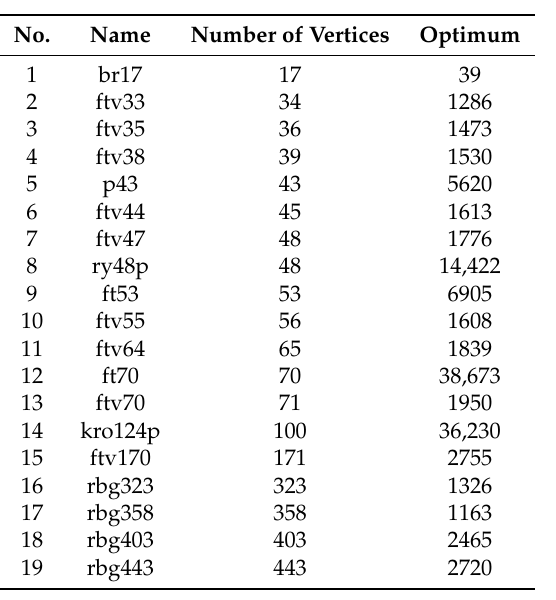
Table 1. Description of benchmark